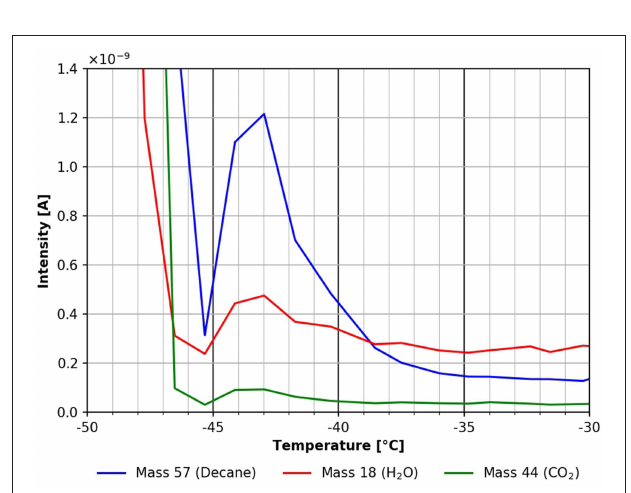
FIGURE 7 | Zoom into the TPD spectrum shown in Figure 6 . n-decane (mass 57, blue), carbon dioxide (mass 44, green), and water (mass 18, red).